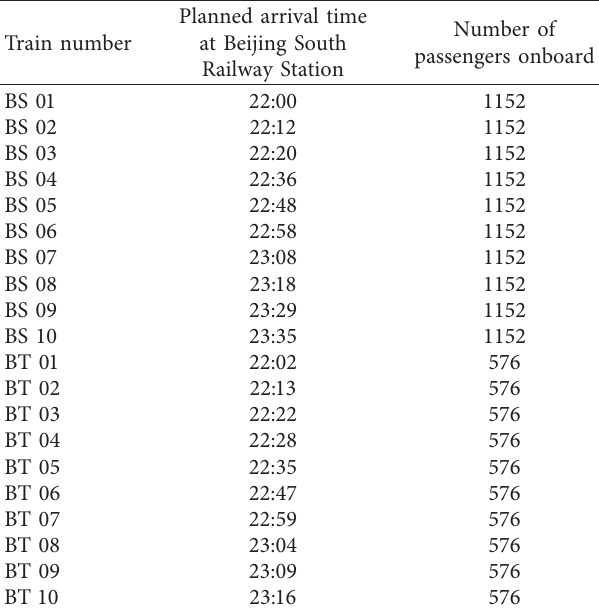
Table 4: Planned arrival time and passenger-carrying volume of HSR trains.